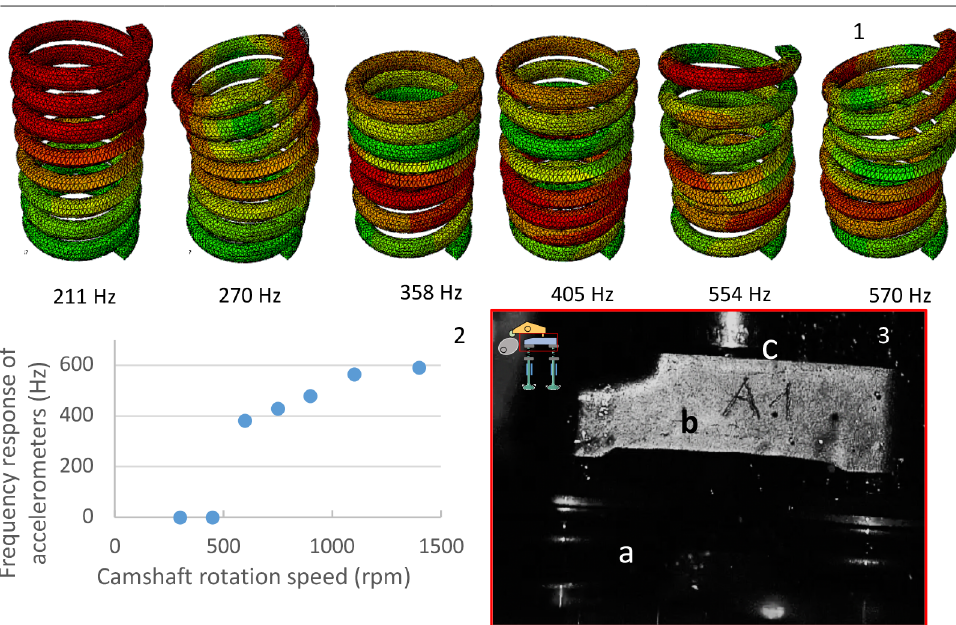
Fig. 12. Characterization of the spring response, (1) natural frequency of resonance of the spring with the mass of the valve applied to the top of the spring, (2) fundamental frequencies from the accelerometer attached to the valves, (3) visualization of the valve actuation with the high-speed camera, a: spring, b: bridge, c: rocker arm.